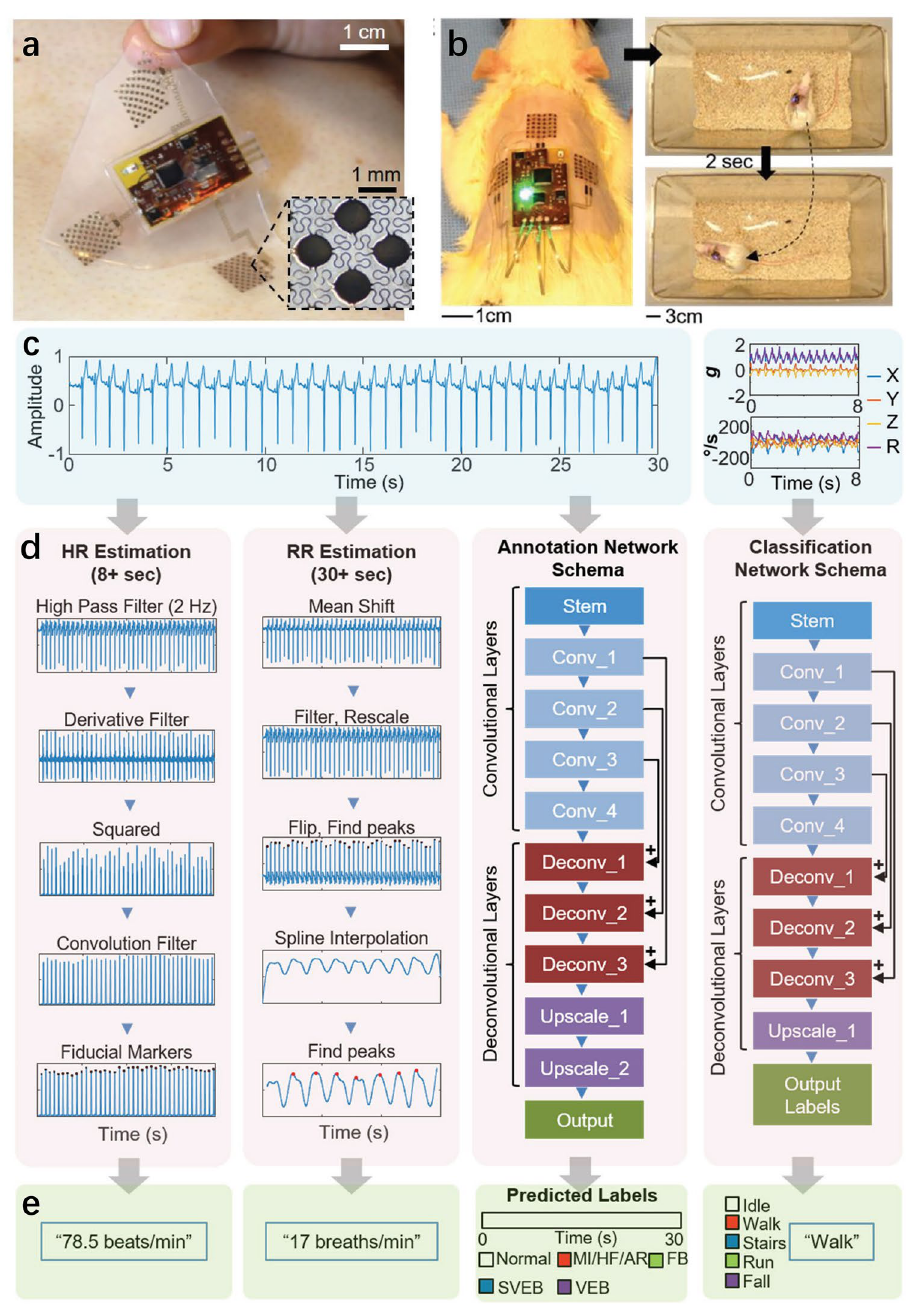
Fig. 26 ECG signals detected by soft system and analyzed by CNN. a Photograph of an SHE system laminated on the skin without the use of adhesives. Inset is the patterned Au electrodes. b In vivo animal study of the SHE system, involving ambulatory ECG monitoring of a rat model on its shaved back. c A set of ECG signals measured by SHE system (left) and motion activity, measured by change of acceleration (top right) and orientation (bottom right). d Overview of data processing methods consisting of four columns: HR estimation process, RR estimation pro- cess, ECG classification CNN, and Motion classification CNN. e Each column showing the outputs from the column in d , in the order of HR, RR, ECG annotation, and motion activity class. Reproduced with permission [339]. Copyright (2019),